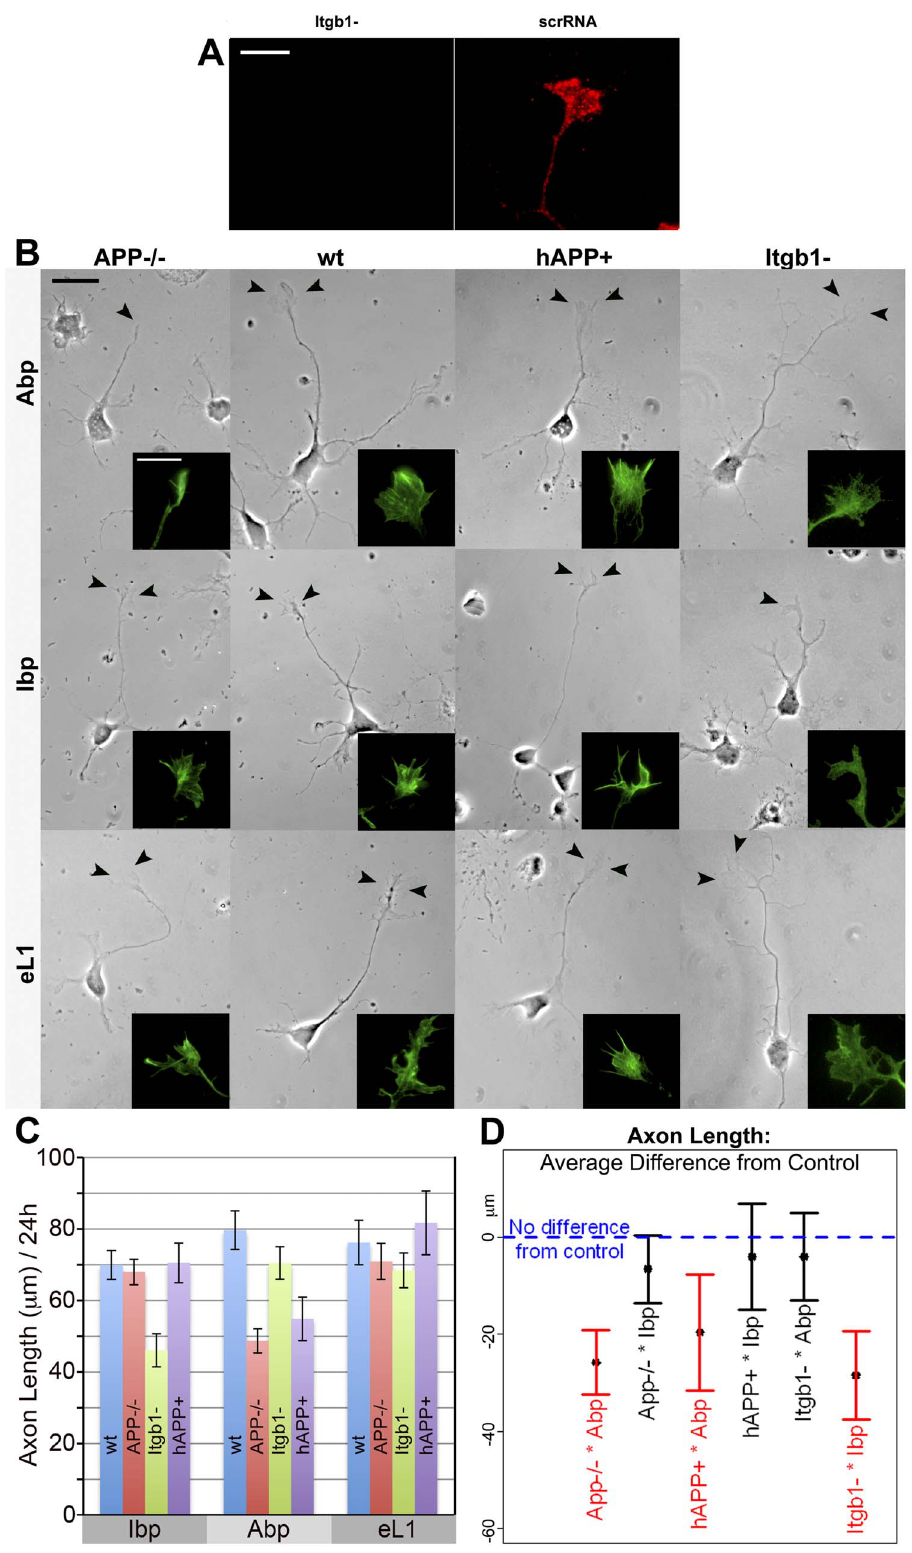
Figure 5. Axon length of APP mutant and Itgb1 2 deficient mouse neurons on monospecific substrates. A. Knock-down of Itgb1 protein in wt GC by siItgb1 (control, scrRNA). Itgb1 fluorescence (red) was not detectable at 24 h in vitro . B. APP mutant and Itgb1 2 neurons on mono- specific matrices for 24 h (phase contrast). Scale 20 m m. Arrow heads point at the axonal GCs. Inserts show these GCs at higher magnification (bar 10 m m) after phalloidin labeling (APP 2 / 2 , wt, hAPP + ) or to reveal the GFP transfection marker (Itgb1 2 ). C. Axon lengths for different neurons on the three growth substrates (bottom labels) after 24 h in vitro (means 6 s.e.). D. Average difference in outgrowth and associated 95% confidence interval